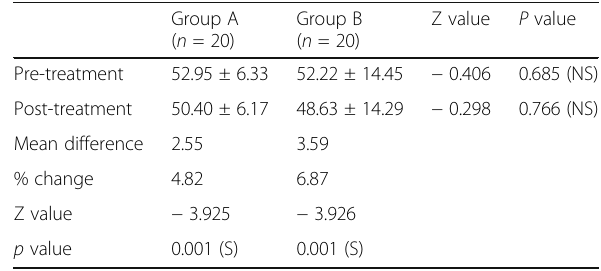
Table 1 General characteristics of both groups Table 3 Comparison between mean scores of Oswestry Disability Index within and between both groups